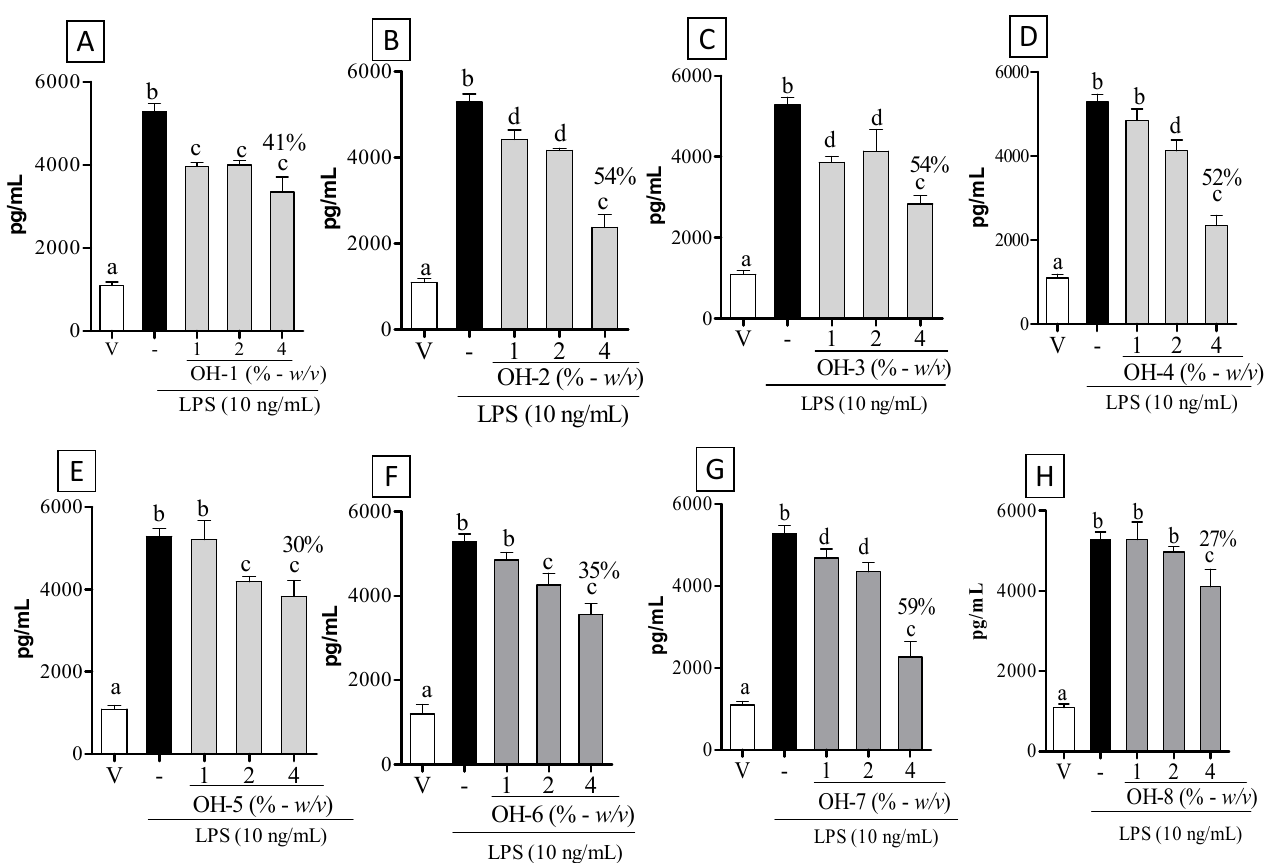
Figure 3. Effect of organic honey (OH-1 to OH-8) in decreasing the release of TNF- α in RAW 264.7 macrophages. Macrophages were treated with vehicle—V (RPMI medium) and LPS (-, 10 ng/mL): ( A ) OH-1, ( B ) OH-2, ( C ) OH-3, ( D ) OH-4, ( E ) OH-5, ( F ) OH-6, ( G ), OH-7, and ( H ) OH-8 in different concentrations for 30 min before LPS stimulation. The negative control group received 0.9% saline (vehicle—V). Different letters indicate statistically significant intragroup differences ( p < 0.05; one-way ANOVA, followed by Tukey’s post-hoc